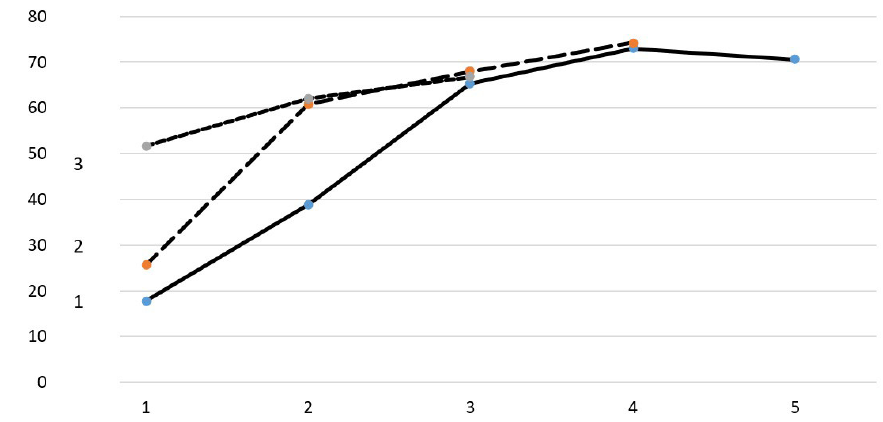
Figure 3. Accuracy of expression recognition with expanding the range of spatial frequencies that used for the facial stimuli. For function 1, the expansion of the frequency range starts from a frequency of 4 CPI, for function 2 - from 8 CPI, for function 3 - from 16 CPI. On the x-axis is the width of the frequency band of the stimulus in octaves. The y-axis shows the percent of correct responses.